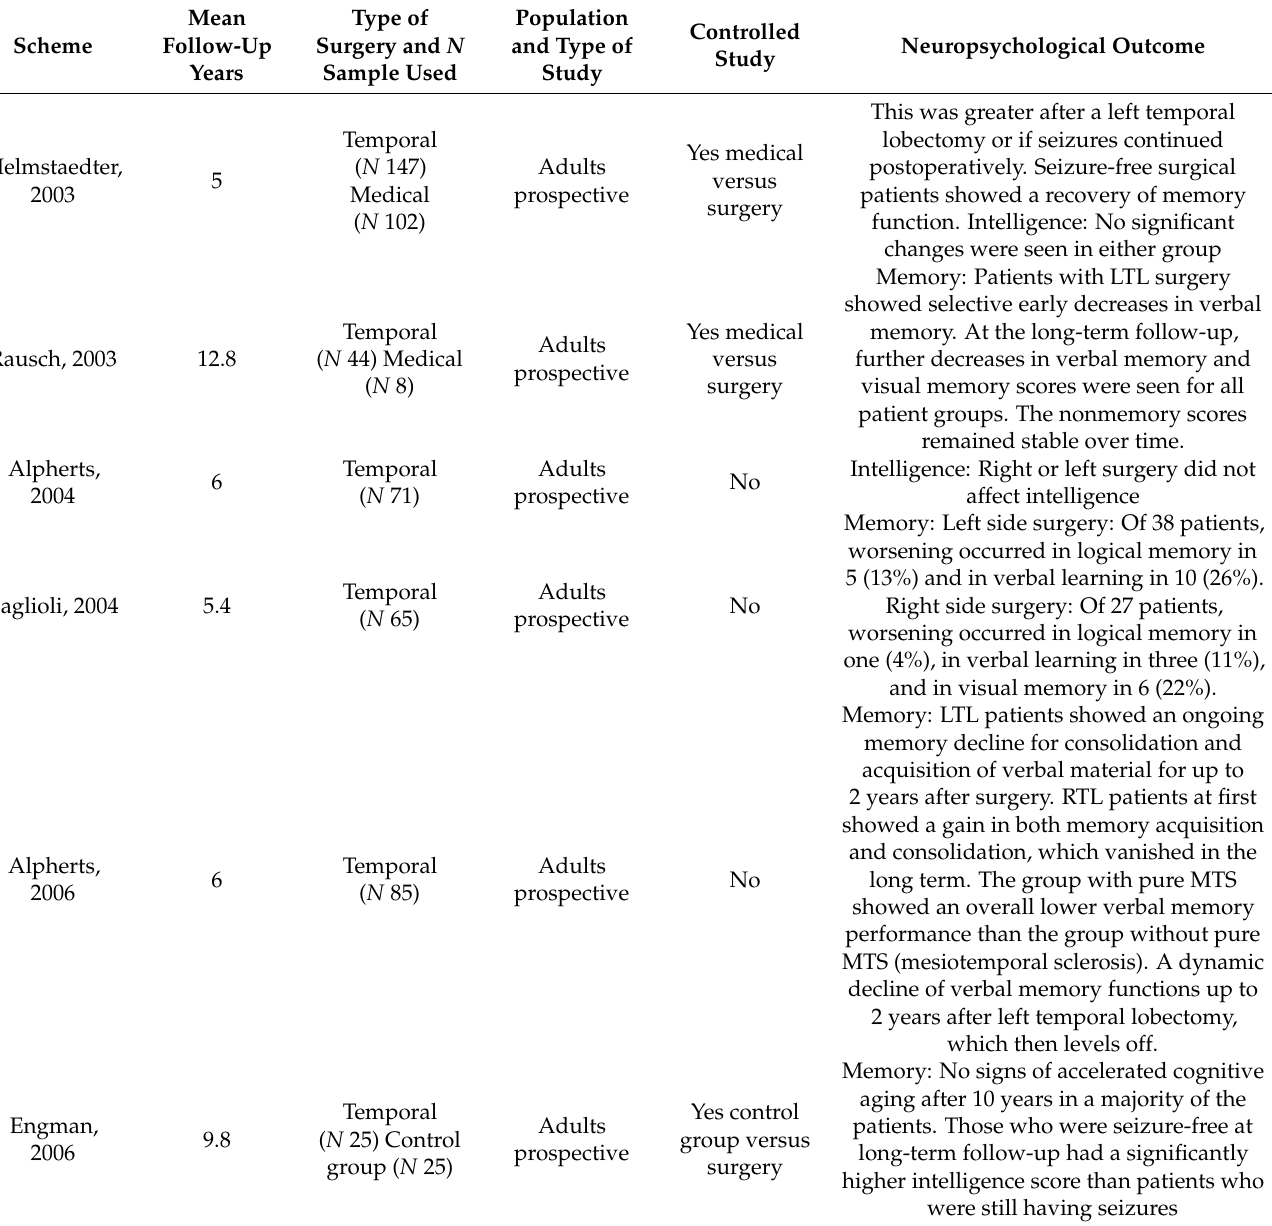
Table 1. Neuropsychological outcome in studies with long-term follow